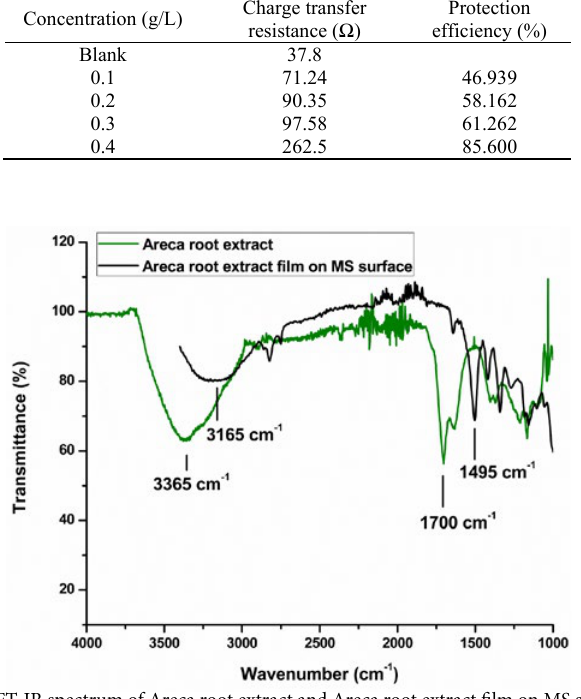
Fig. 8. FT-IR spectrum of Areca root extract and Areca root extract film on MS Fig. 8 . FT-IR spectrum of Areca root extract and Areca root extract film on MS surface